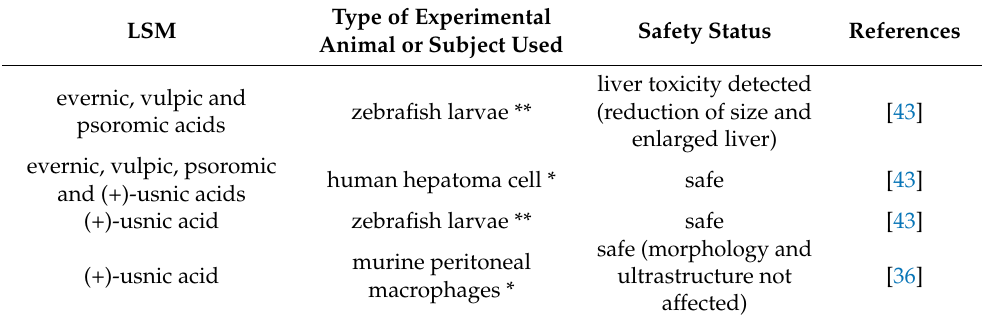
Table 6. The results of documented toxicological tests of LSMs applied to determine safety